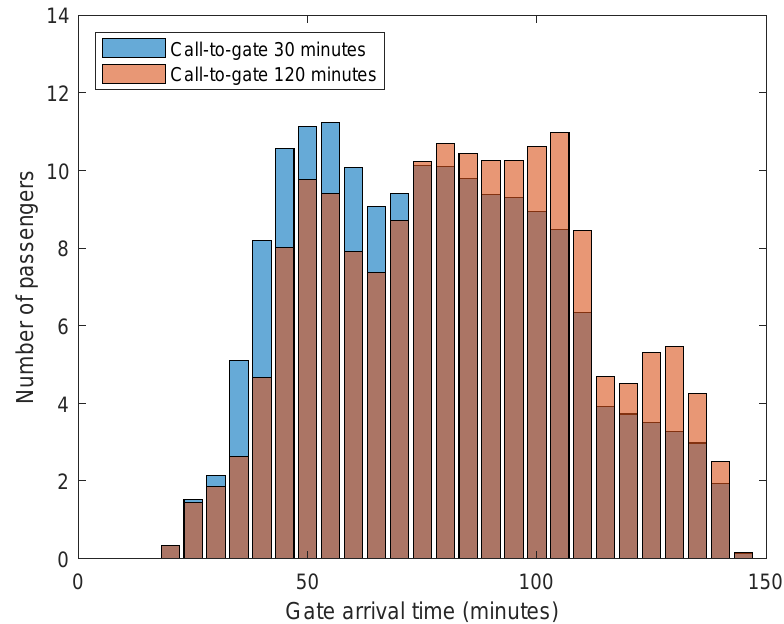
Figure 7. The average number of passenger agents that arrive at the gate, indicated in minutes before departure. The indicated number of passengers represents the mean value of 1000 simulation runs for that call-to-gate time.